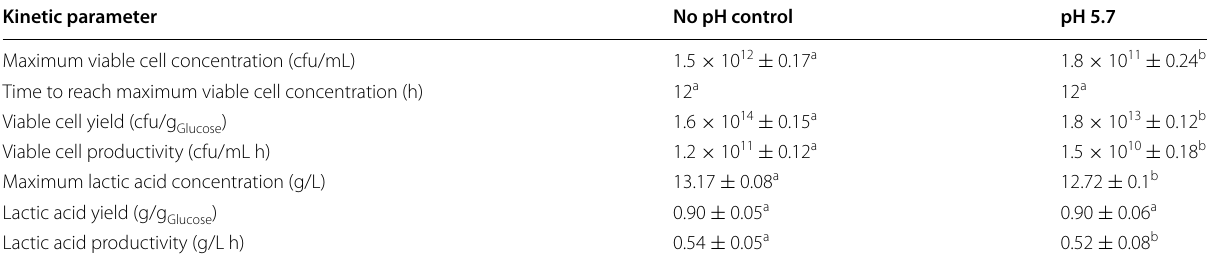
The results presented are the average of triplicate experiments and are expressed as mean a,b Mean values in the same row with different superscripts are significantly different from each other (P < 0.05)